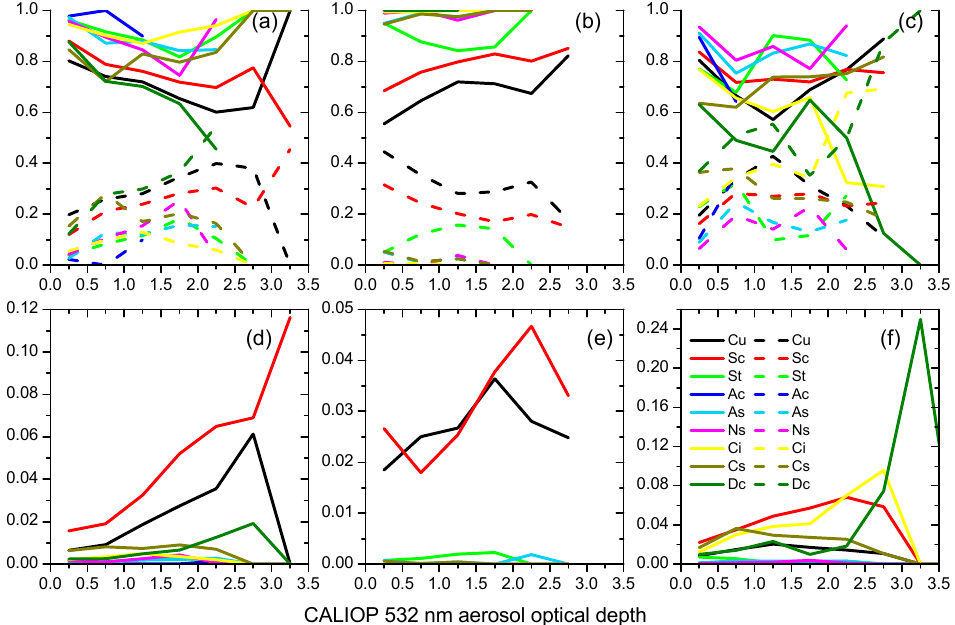
Figure 7. The variation of the proportion of consistent (solid lines) and non-consistent (dashed lines) MODIS and CALIOP cloud detection data with AOD for different cloud types over ( a ) dark, ( b ) bright, and ( c ) water surfaces, respectively, and the variation of r_MODcloud_CALfree for each cloud type with AOD over ( d ) dark, ( e ) bright, and ( f ) water surfaces, respectively.